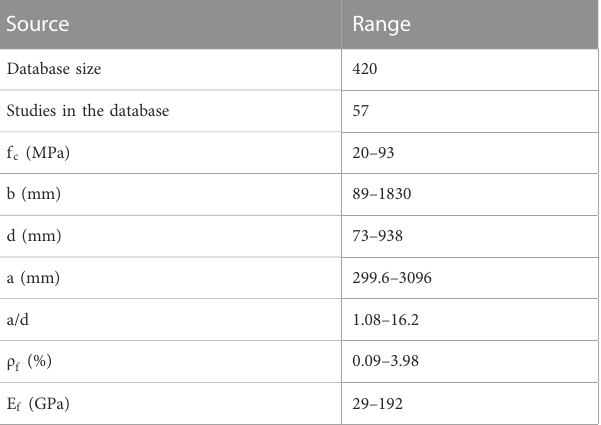
TABLE 1 Database of parameters for slender FRP-RC elements under shear.